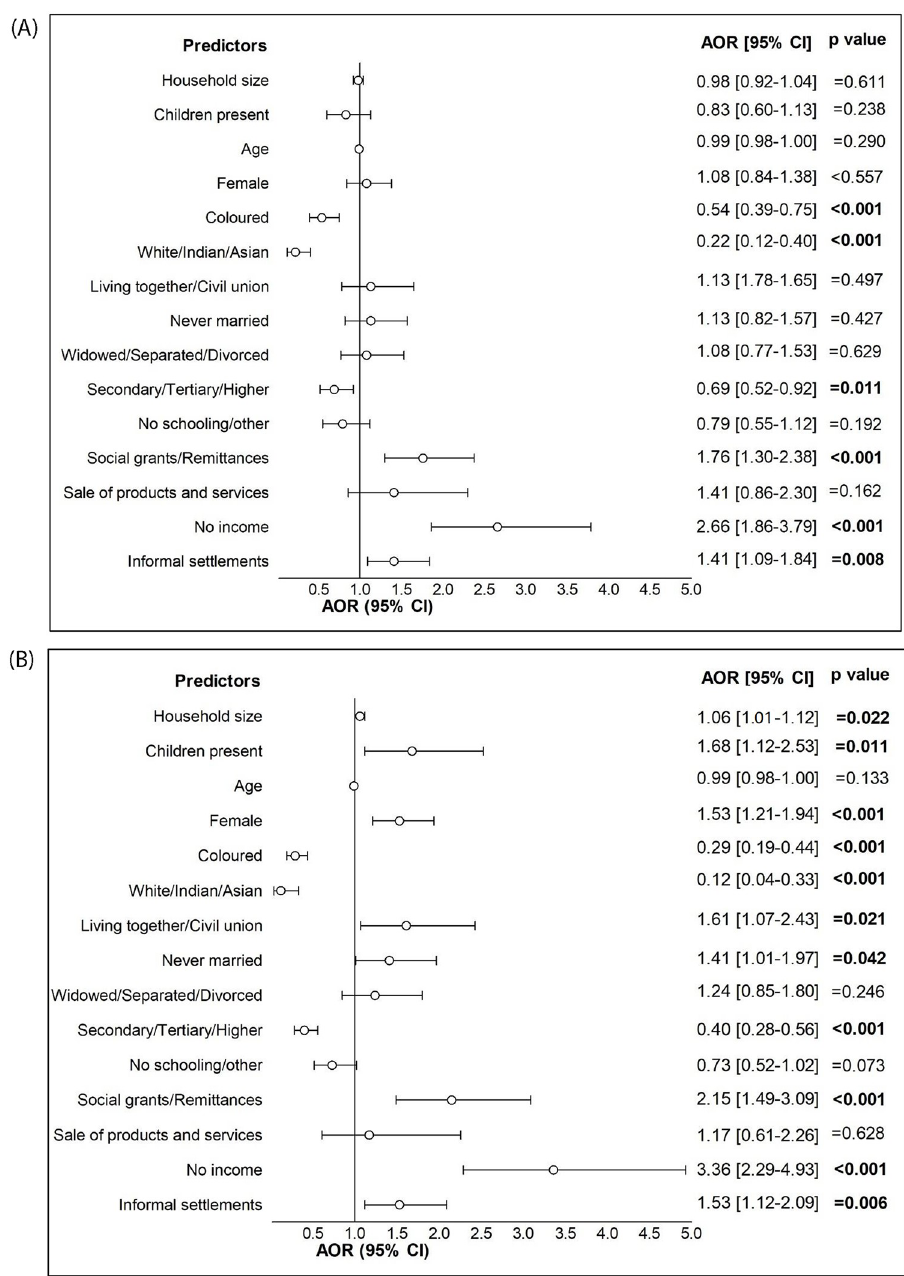
Fig 2. A. Factors associated with being at risk of hunger, data presented as adjusted odds ratios (AOR) and 95% Confidence intervals (95% CI). Reference categories : Presence of children (no children present) , Gender (male) , Race (African) , Marital status (married) , Educational attainment (primary) , Source of income (salaries/wages) , Locality (formal) . Factors associated with experiencing hunger, data presented as adjusted odds ratios (AOR) and 95% Confidence intervals (95% CI). Reference categories : Presence of children (no children present) , Gender (male) , Race (African) , Marital status (married) , Educational attainment (primary) , Source of income (salaries/wages) , Locality (formal)